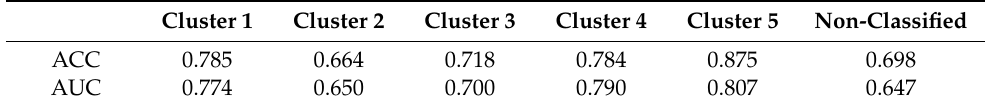
Table 9. The predictive results of logistic regression using the test datasets.